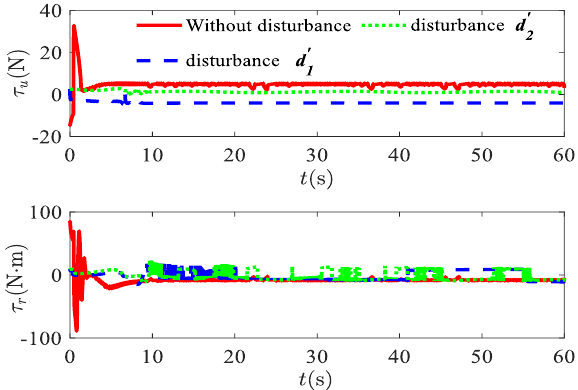
Figure 8. Surge force and yaw moment in three cases.